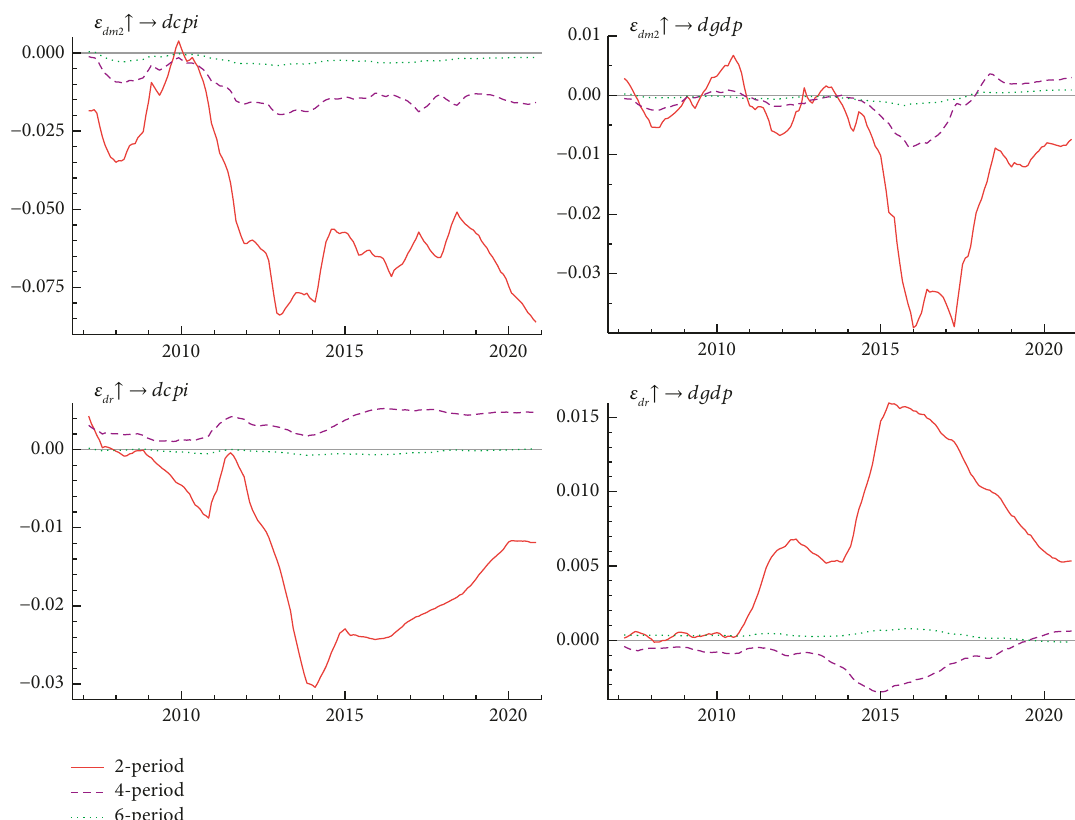
Figure 9: The impulse responses of monetary policy to macroeconomy with an equal Figure 8. First, the money supply had a positive effect on the